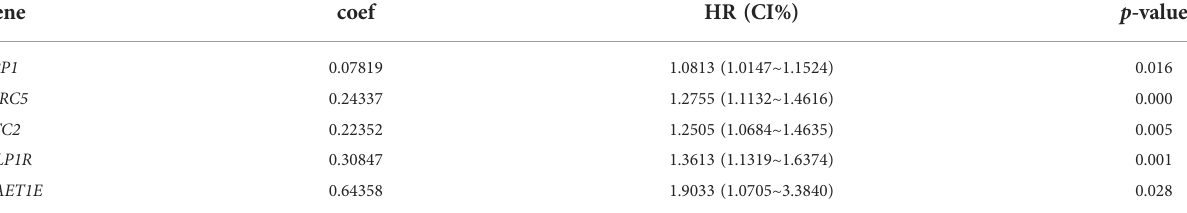
TABLE 1 Multivariate Cox regression analyses of fi ve IRGs in risk models in HCC.